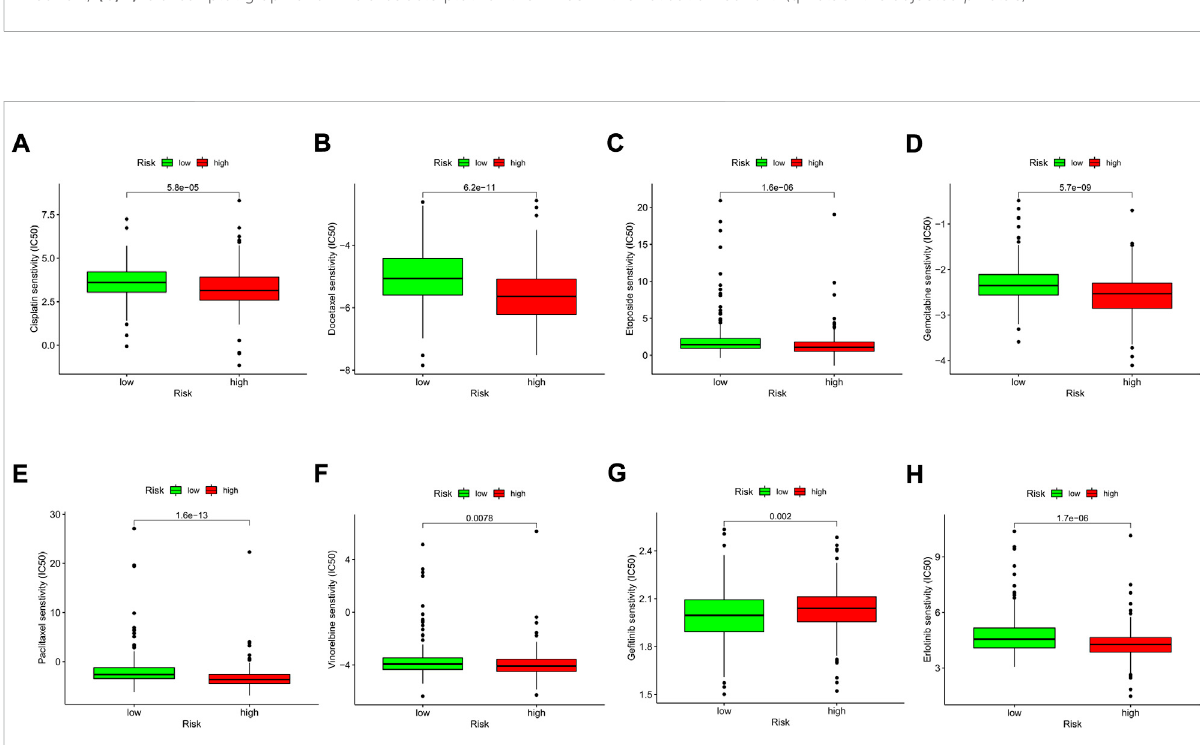
FIGURE 12 Comparison of the drug sensitivities between low- and high-risk LUAD patients. (A – H) Comparison of the IC50 of each drug between the two risk groups.